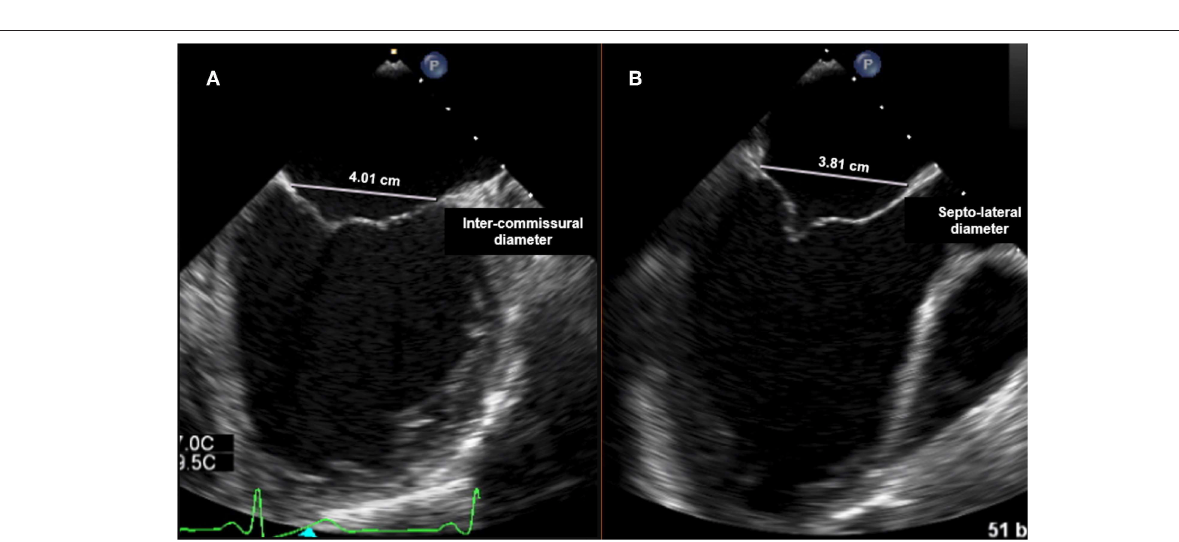
FIGURE 2 | Transesophageal echocardiography (TTE): (A) intercommissural view focused on MV for intercommissural diameter measurement; (B) mid-esophageal Long-axis view (ME LAX View) for septo-lateral (antero-posterior) annulus